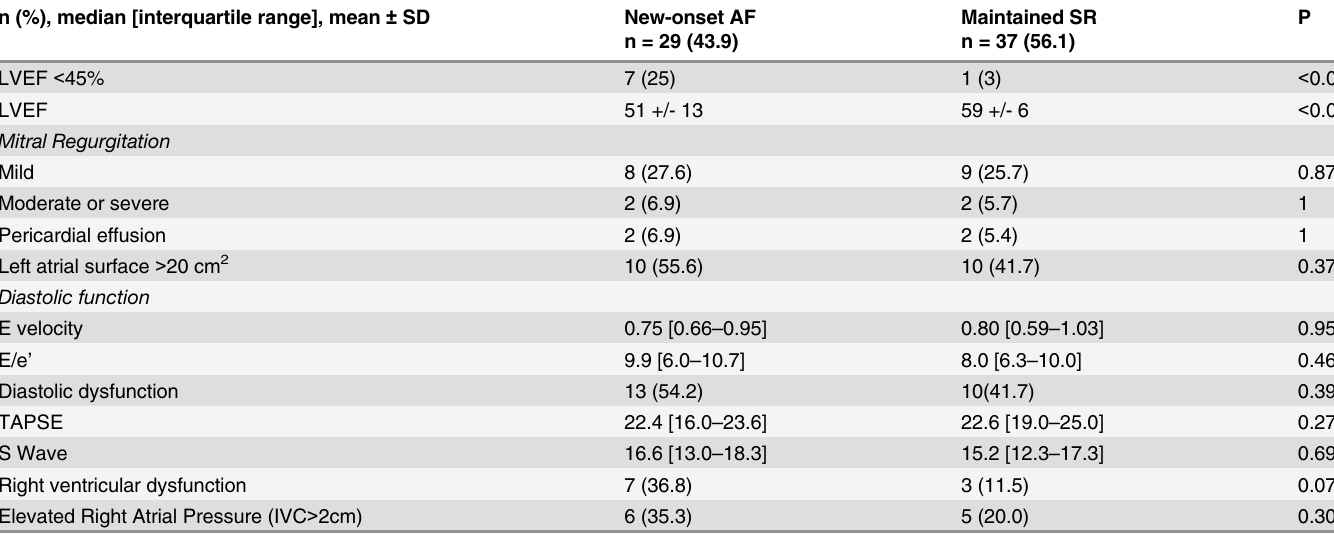
AF indicates atrial fi brillation; IVC: inferior vena cava; LVEF: left ventricular ejection fraction; TAPSE: tricuspid annular plane systolic